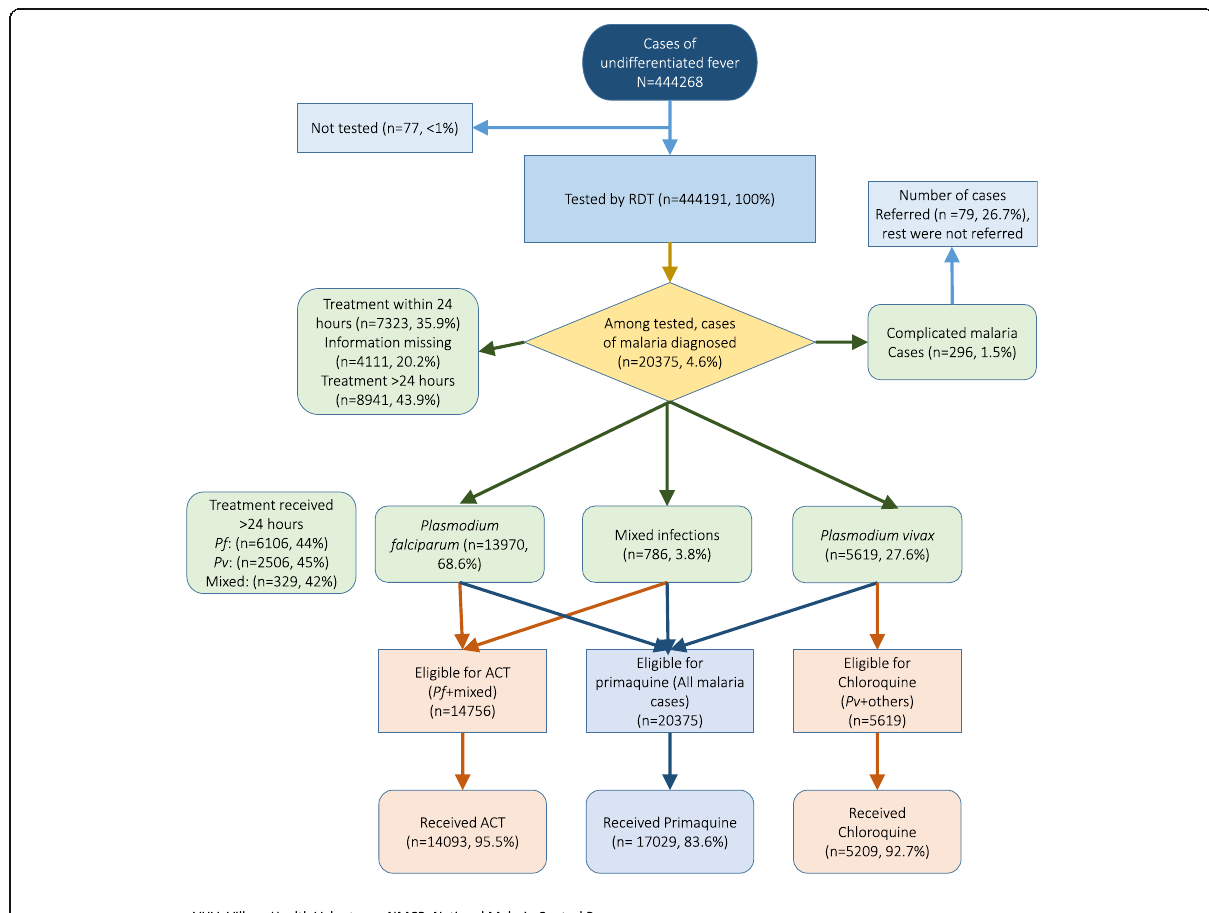
Fig. 2 Flowchart showing the cascade of malaria care (testing, diagnosis, and treatment) among patients with undifferentiated fever identified by VHVs under NMCP in Myanmar,